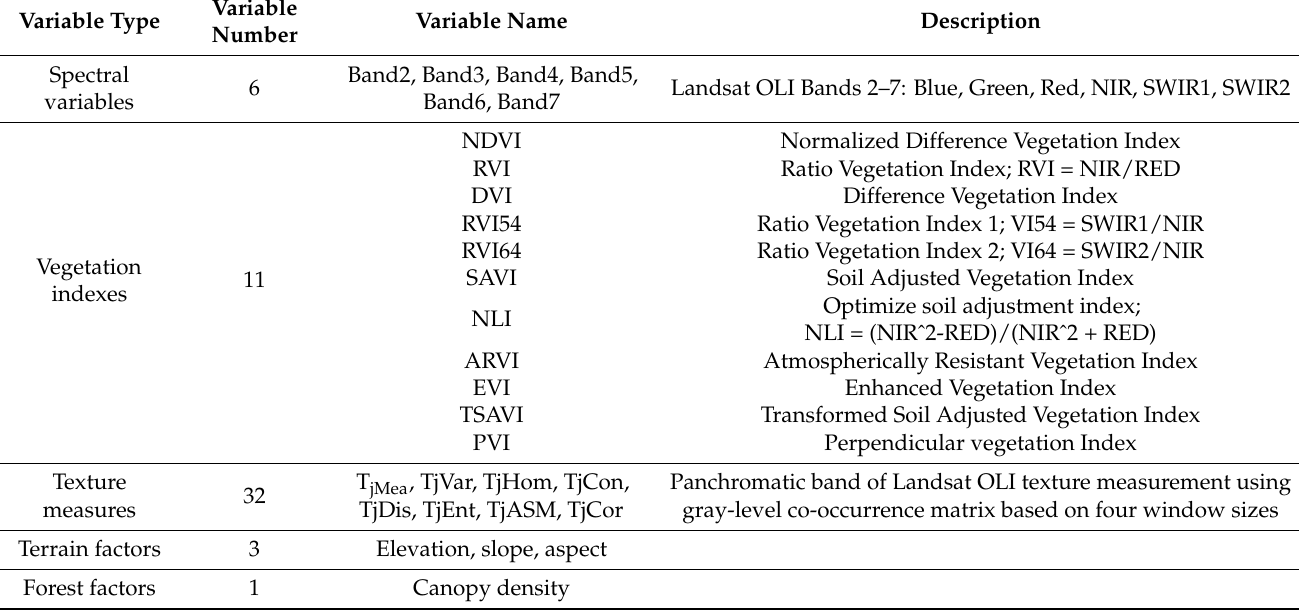
Table 4. Summary of predictor variables including Landsat OLI spectral variables, vegetation indexes, texture measures, terrain factors, and forest factor for AGB estimation.